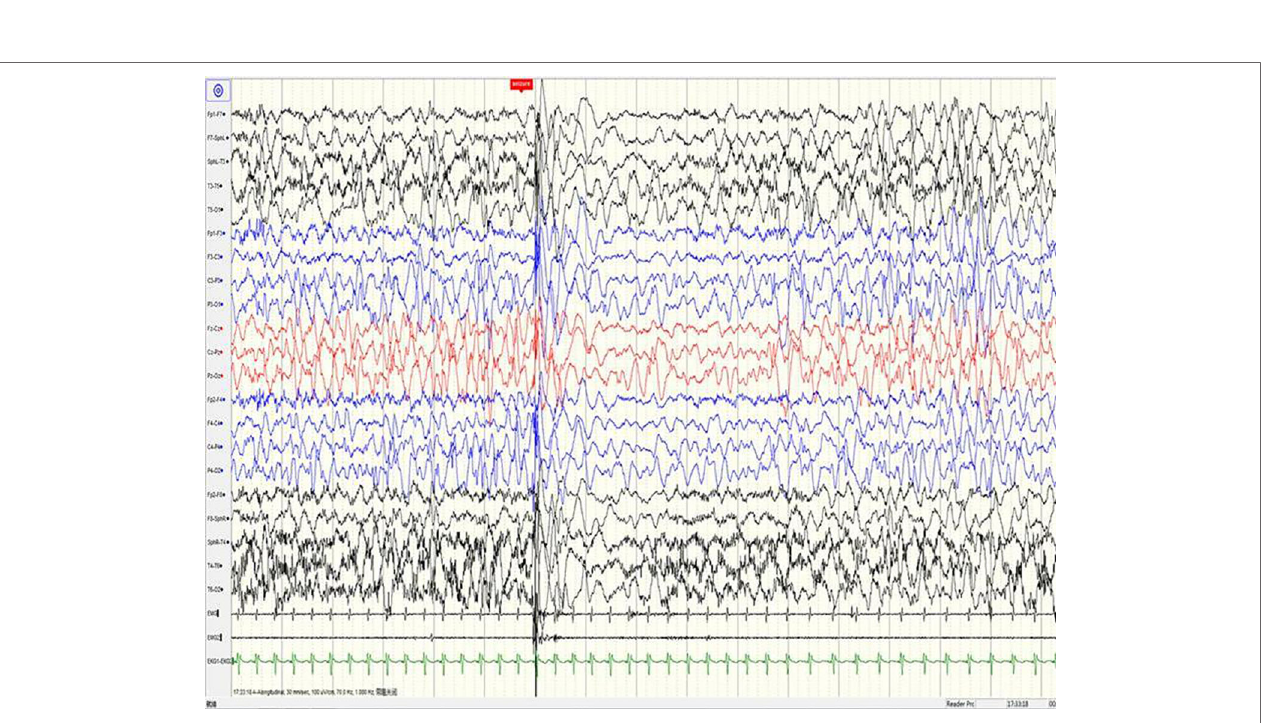
FIGURE 4 | A sample EEG recording of 8-month-old child in this study. The seizures are characterized by left oblique movement of both eyes and limb fl exion uplift; the same period of the EEG signals show bilateral lead extensive spike-slow wave and myoelectric outbreak in the bilateral deltoid muscle.